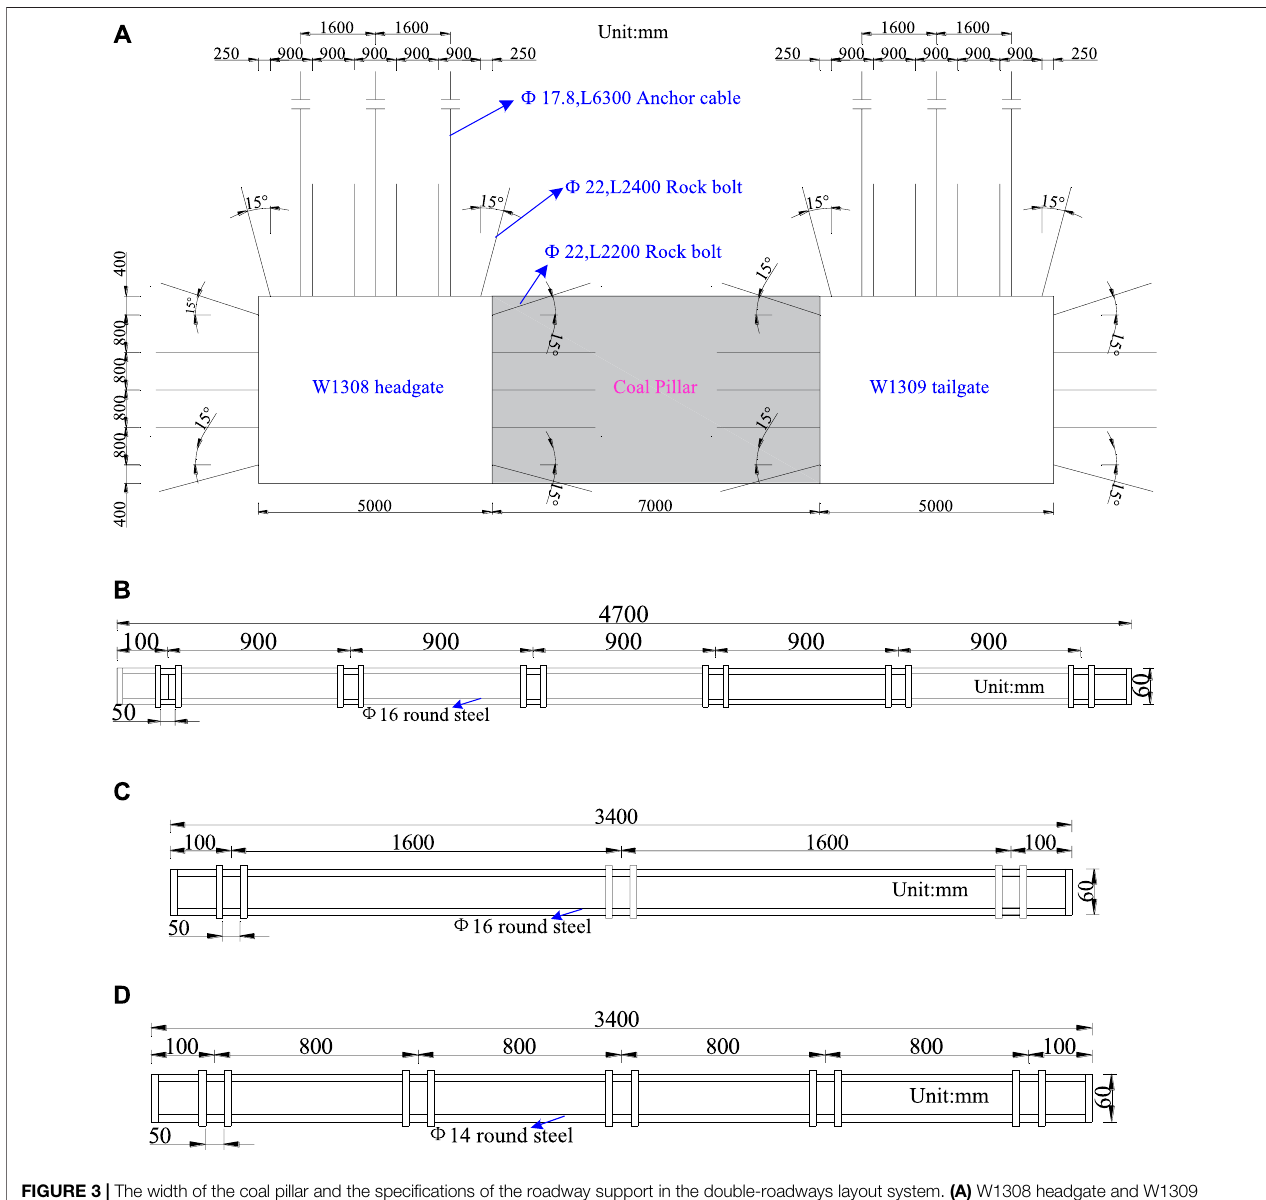
FIGURE 3 | The width of the coal pillar and the speci fi cations of the roadway support in the double-roadways layout system. (A) W1308 headgate and W1309 tailgaterockboltsandanchorcablessupportsectionaldrawing; (B) Thedimensionsofreinforcedladderbeamofroofrockbolts; (C) Thedimensionsofreinforcedladder beam of roof anchor cables; (D) The dimensions of reinforced ladder beams of two ribs rock bolts.